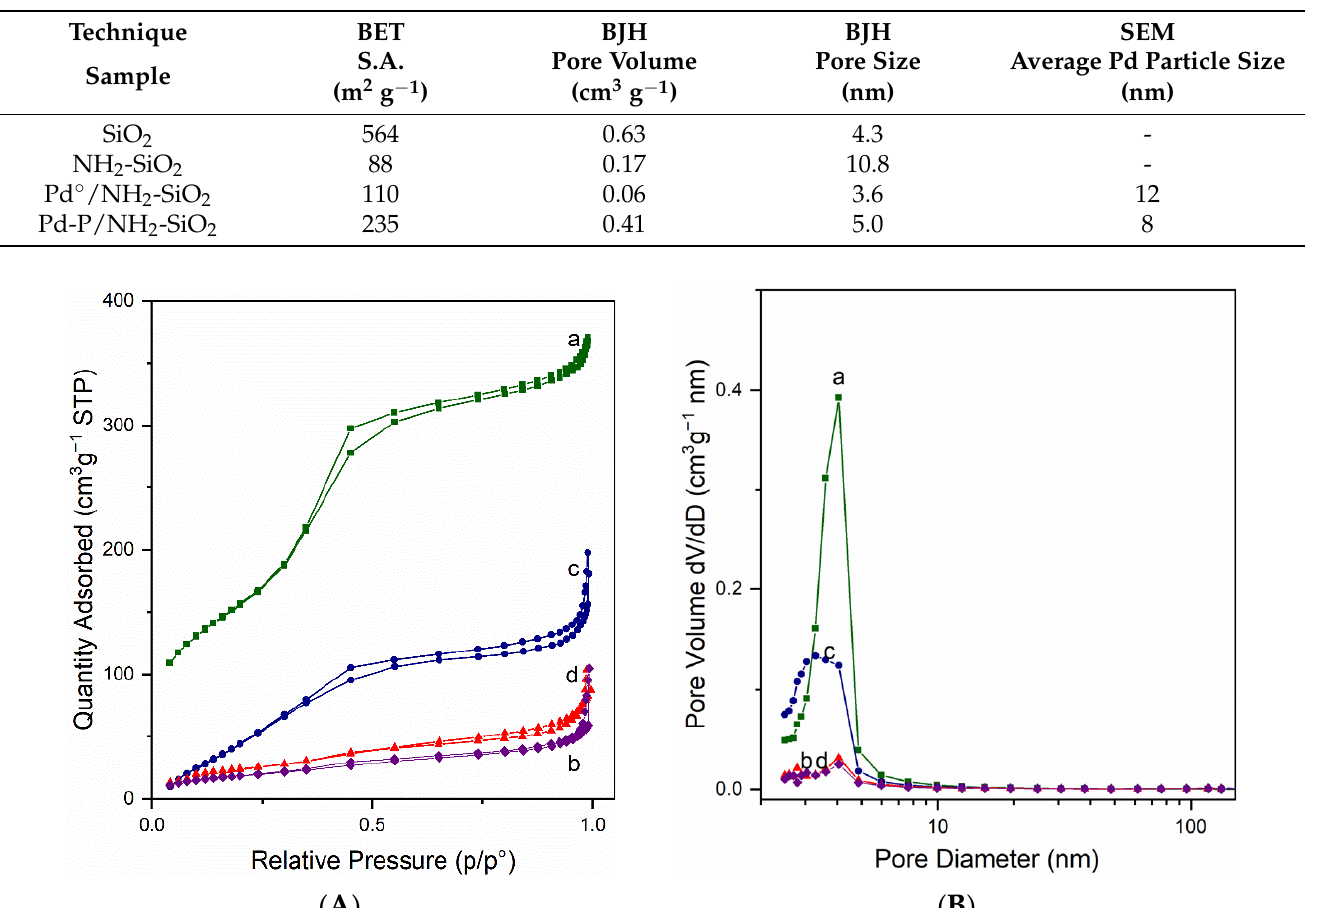
Table 1. Morphological properties of the samples by Brunauer–Emmett–Teller (BET) surface area (S.A.) analysis, Barrett–Joyner–Halenda (BJH) pore analysis and scanning electron microscopy (SEM).